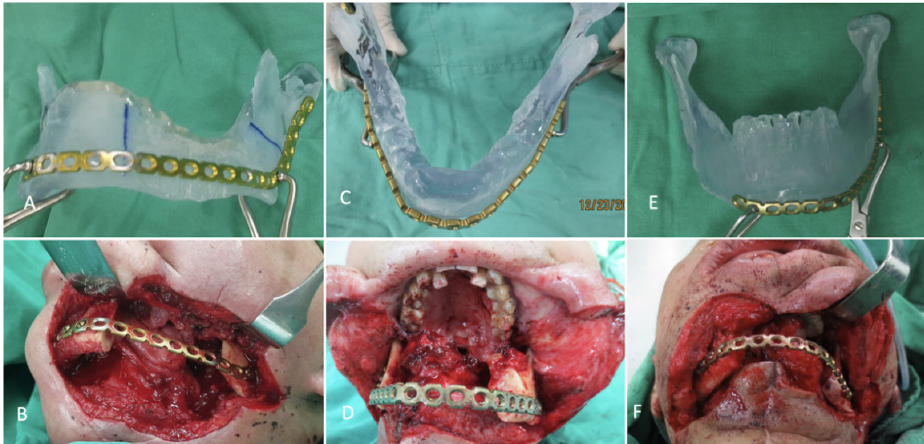
Figure 5. Manual bending of reconstruction plate. ( A , B ) Contouring of reconstruction plate on 3D printed model and adapting in the patient in category I. ( C , D ) Contouring of reconstruction plate on 3D printed model and adapting in the patient in category II. ( E , F ) Contouring of reconstruction plate on 3D printed model and adapting in the patient in category III.